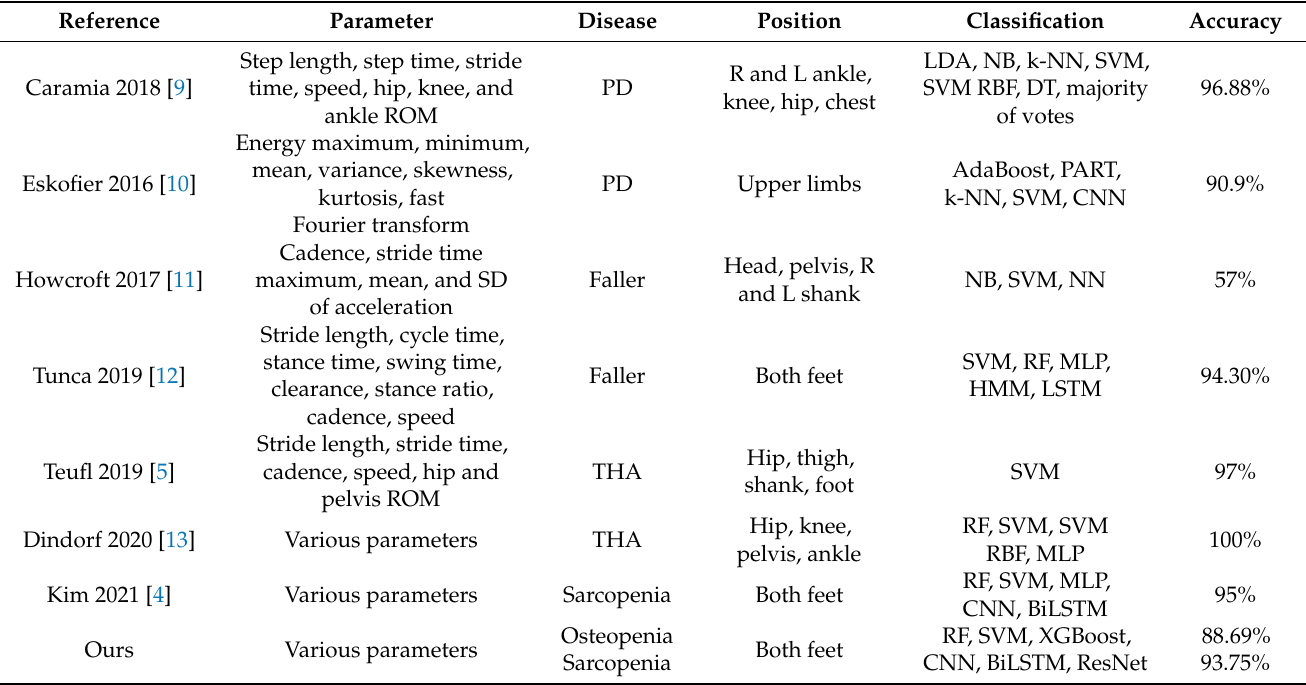
Table 1. Existing studies on disease identification using gait parameters. Abbreviations are as shown in Table